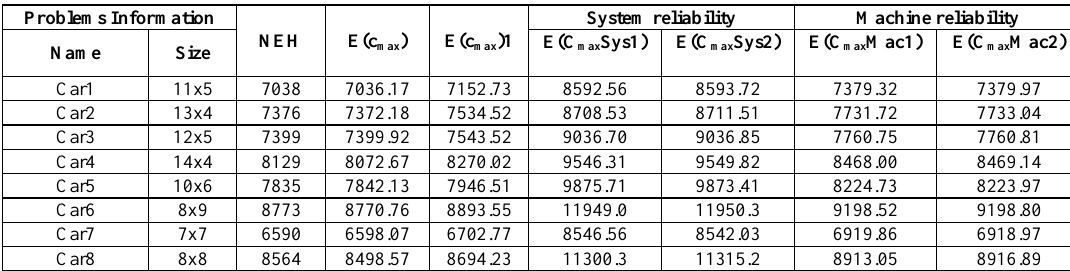
Table 1. Computational results for car problems normally distributed.